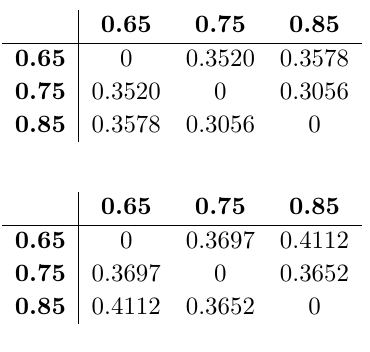
Table H.2. Average Hellinger distances between any two topics paths generated from corpora with various smoothing parameters as the column/row